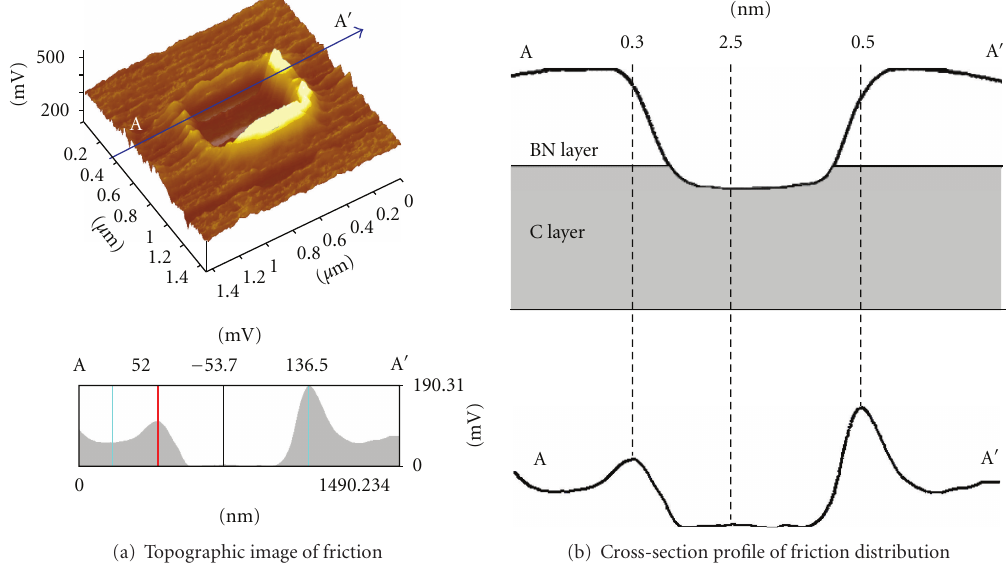
(b) Cross-section profile of friction distribution Figure 18: (a) Profile and cross-sectional images of friction distribution and (b) model of friction versus wear track for 4-nm-period (BN/C)n film at 1000 nN load and vibration amplitude of 20